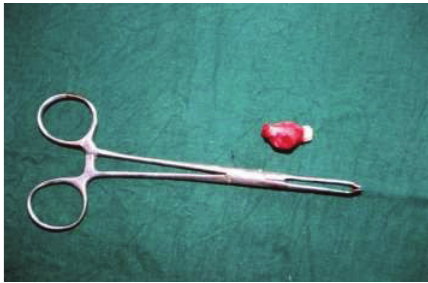
Figure 4: Macroscopic view showing tooth masses with attached soft